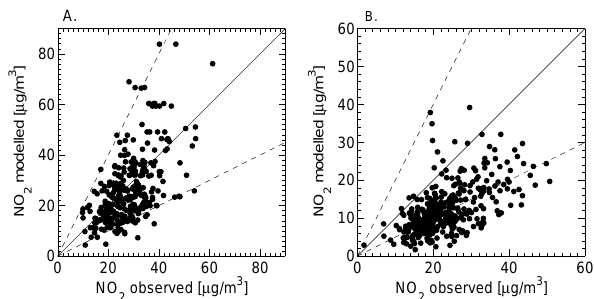
Fig. 6. Comparison of modelled (explained) vs. observed NO 2 ur- ban background concentrations: (A) urban background stations in cities for which an urban polygon is defined, (B) urban background stations in cities for which no urban polygon is defined (7 × 7km grid value is taken here).